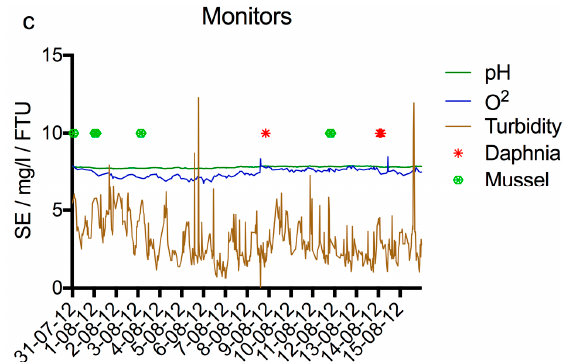
Figure 8. The response of the sensor, compared to other (bio)monitors at the Keizersveer monitoring station, Hank. For the Daphniatoximeter and the Musselmonitor only the alarms are shown. All bacterial sensor measurements were performed with 0.2% LB and continuous exposure to Meuse water. The vertical bars indicate when spikes of nalidixic acid were added to the water in the sensor. The duration of the spikes was always one hour. Graph ( a ) shows the unaltered signal of the sensor, while in graph ( b ) the average background was subtracted from the original response. The signals from the other (bio)monitors are shown in graph ( c ) (FTU: Formazine Turbidity Units, SE: standard pH units).